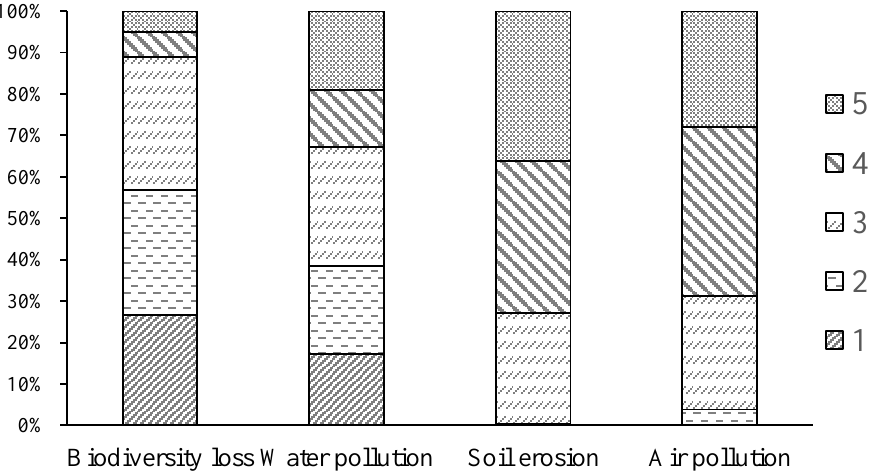
Figure 3. Farmers’ perception of the ecological benefits of the GGP (1 = much worse, 2 = worse, 3 = no change, 4 = improved, 5 = greatly